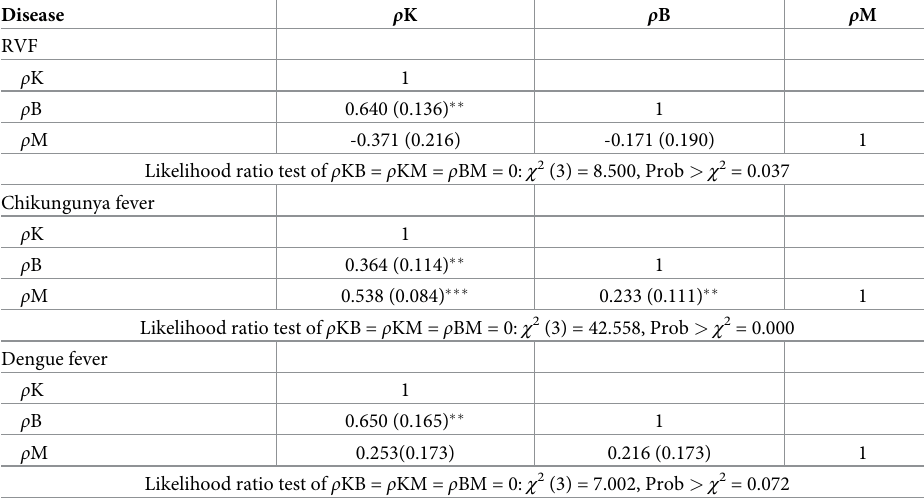
Table 4. Correlation coefficients of the error terms of the MVP